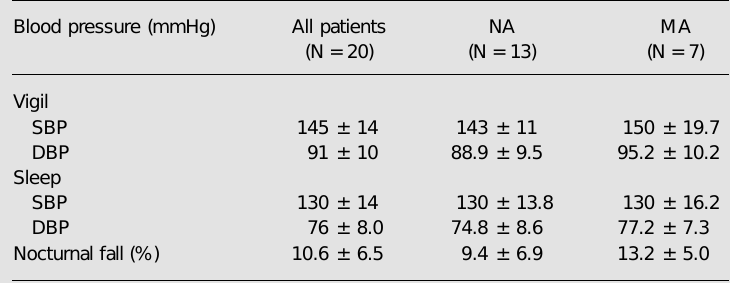
Table 2. Blood pressure obtained by 24-h ambulatory blood pressure monitoring of the NA and MA